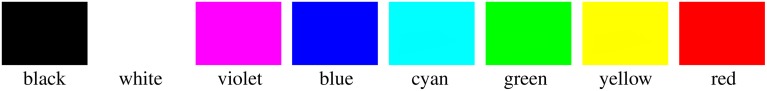
Selection of colors that can be applied to the background and ranges of the plotted matrix.